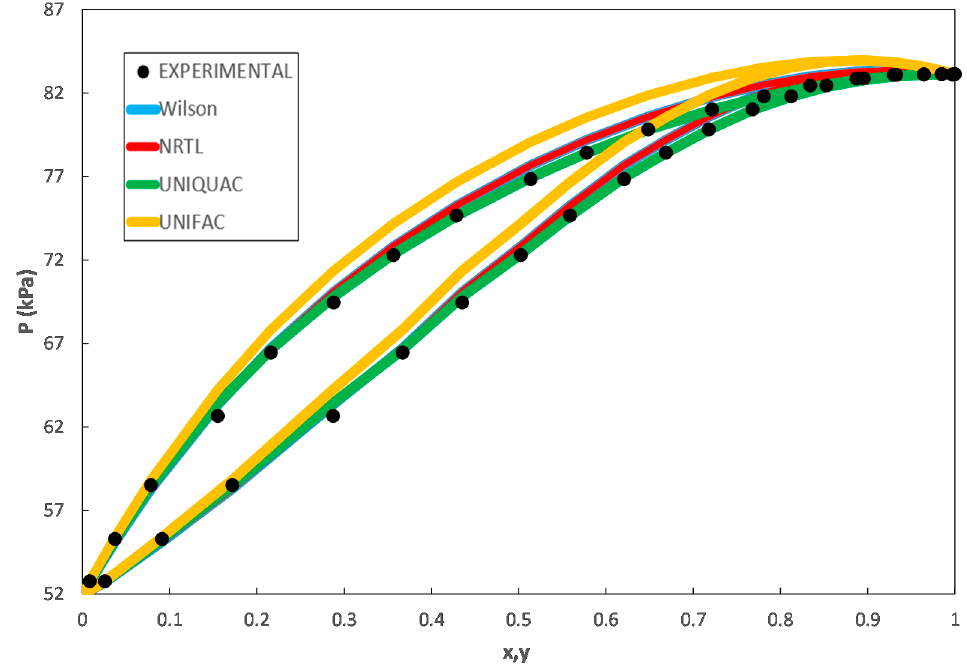
Wilson, NRTL, UNIFAC, and UNIQUAC as predictive models.